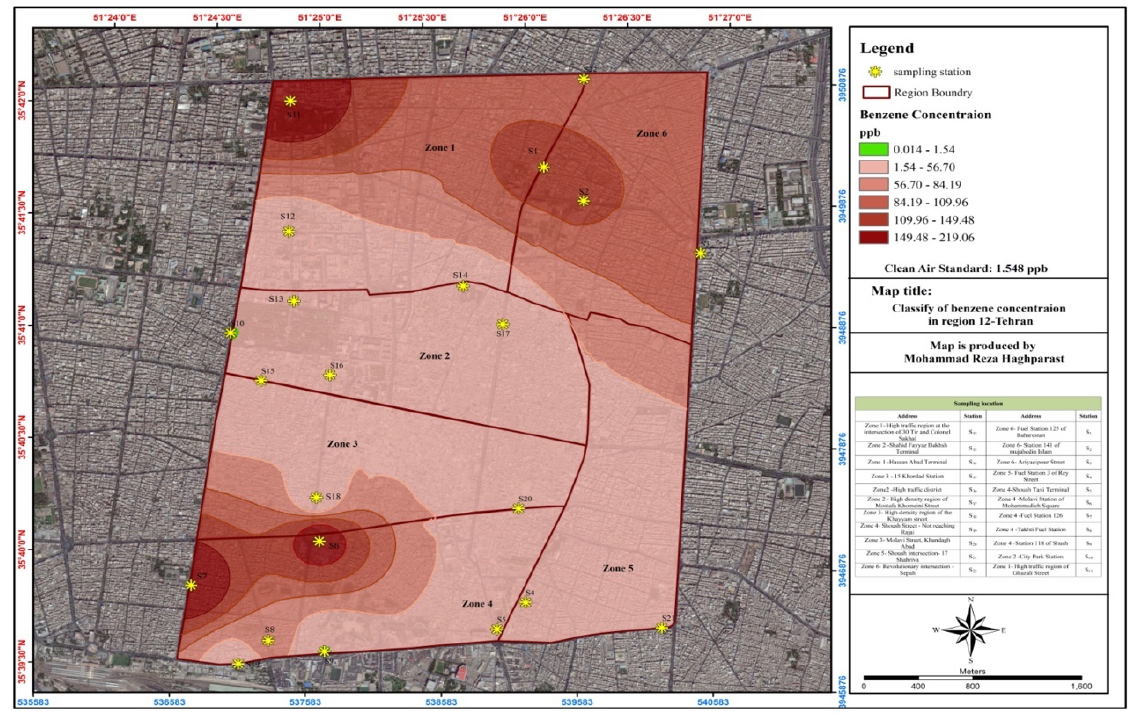
Figure 8. Zoning Benzene concentration in the region on January, 2018 Predictive results show the highest concentrations were observed in the west and north of the zone 4 and boundary between zones 1 and 6. The concentration of benzene in the region (Figure 8) varies between 13.04 – 388.71 ppb. Results show the highest concentrations of toluene were observed in Zones 6, 1 and part of 4. Its concentration is varies between 5.99 - 942.8 ppb.